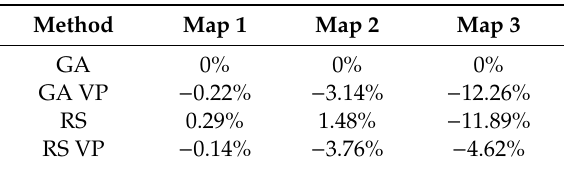
Table 6. Percentage difference between travel times of the methods. The genetic algorithm with approximation (GA) times as a reference.